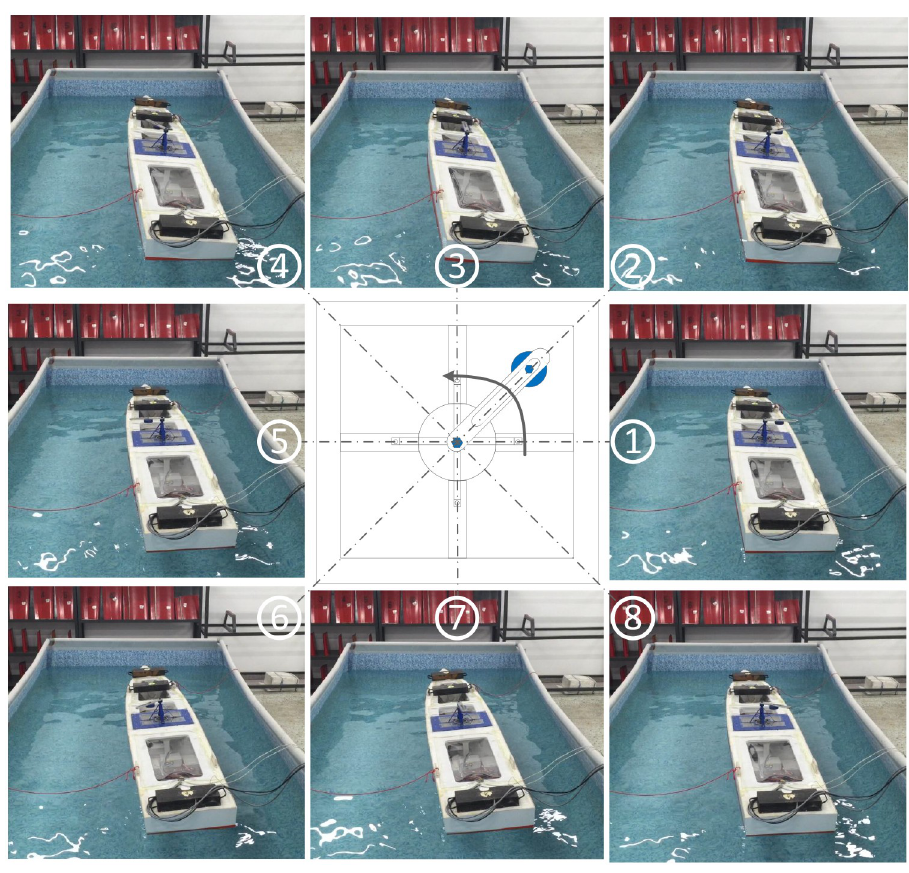
Fig 11. Motion of the forced roll